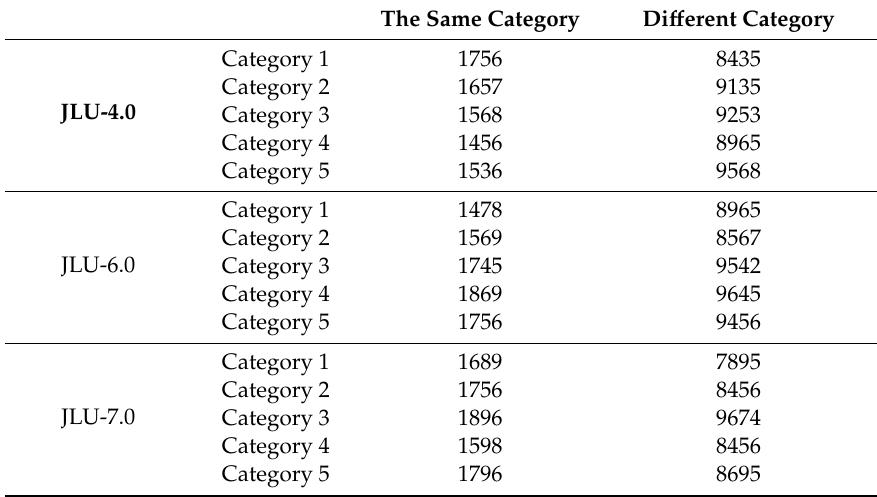
Table 17. Certification times of each category in di ff erent iris